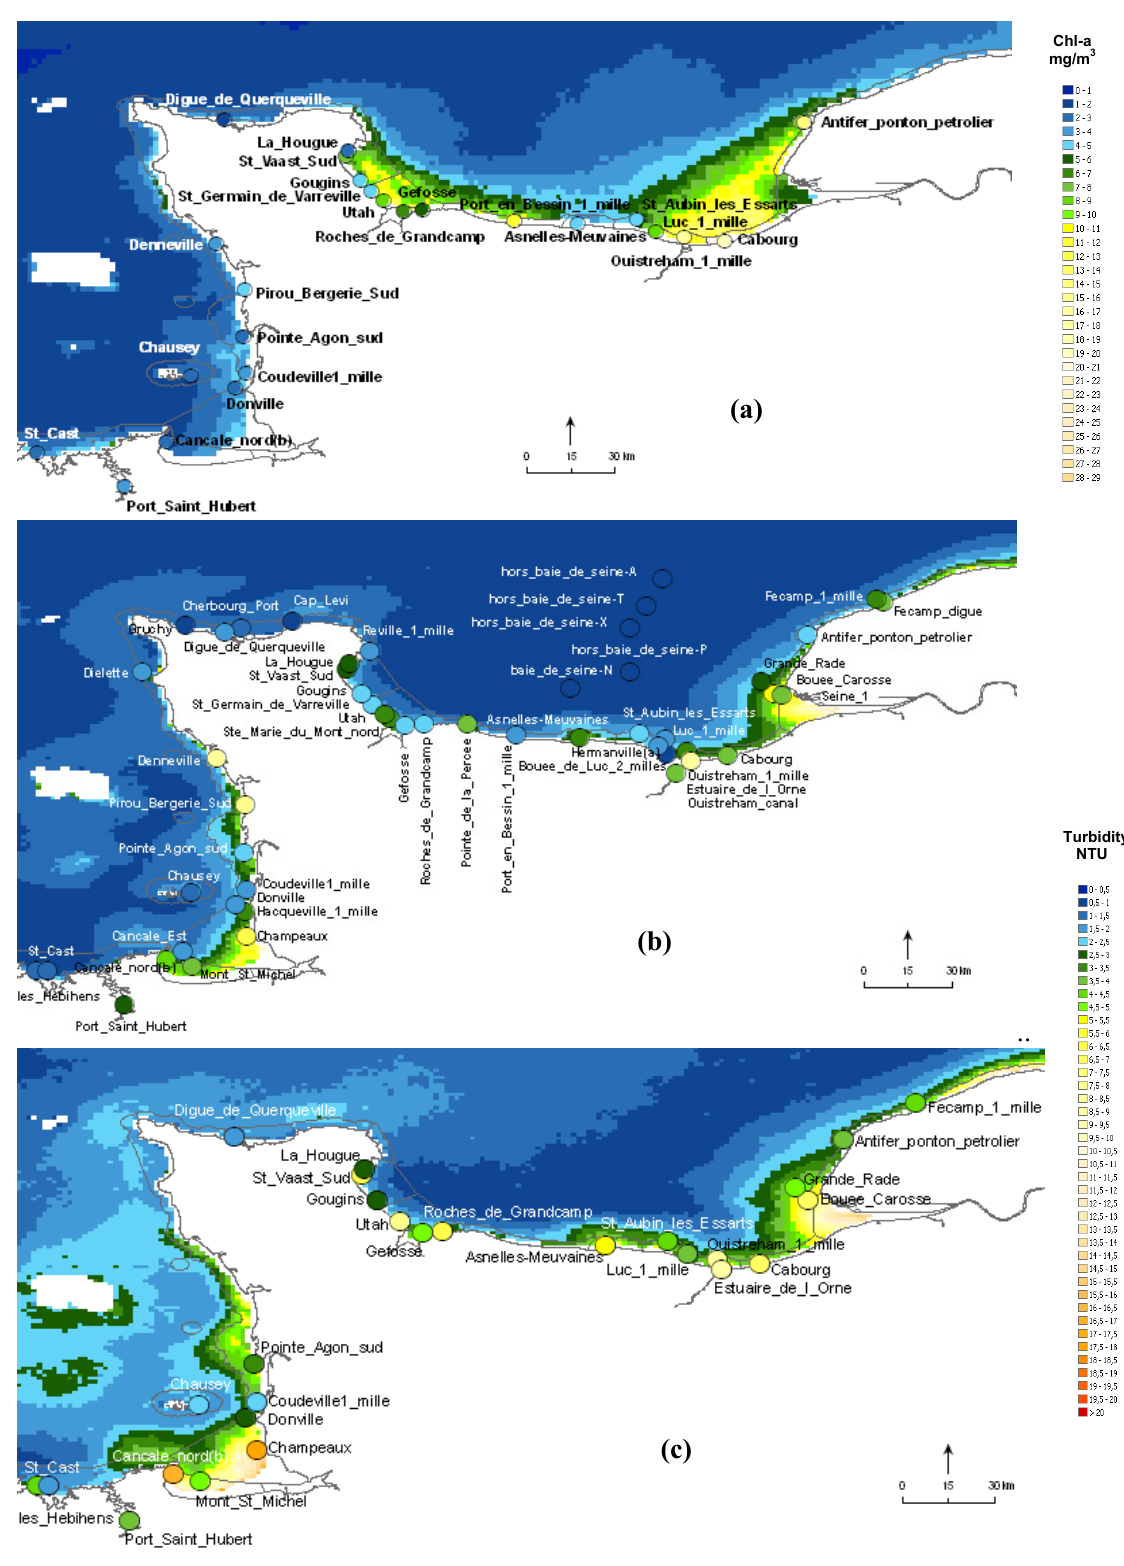
Fig. 15. Percentile 90 of the surface chlorophyll during the productive season (a) and mean turbidity during the productive season (b) and in winter (c) around Normandy. All the in-situ stations are reported on the maps, whatever the number of samples. Ocean Sci., 7, 705–732,